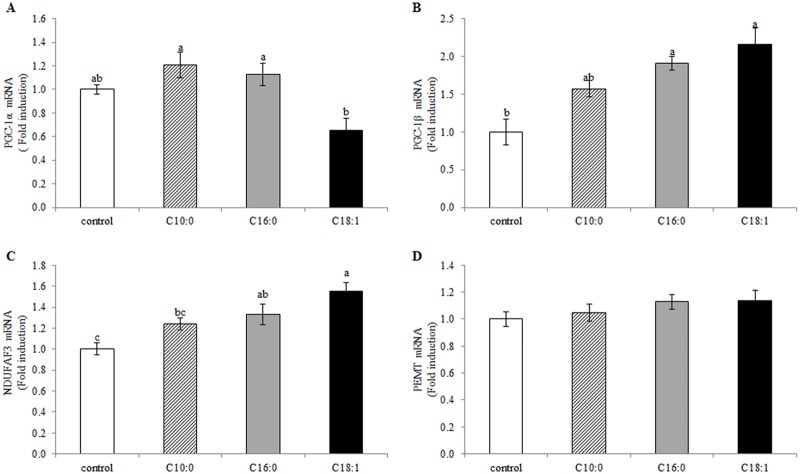
Transcription levels of activity markers of mitochondria and phospholipid converting enzyme are modulated by free fatty acids (FFAs).Mammary epithelial cells were treated with 100 μM FFA (capric, palmitic or oleic acid) or with FFA-free medium (control) for 2 h; RNA was extracted and gene-expression levels of (A) PGC-1α, (B) PGC-1β, (C) NDUFAF3 and (D) PEMT were analyzed by real-time PCR. All data are presented as mean ± SEM of the expression level of the assayed gene normalized to the geometric mean of two housekeeping genes. Different letters indicate significant differences between treatment groups (P < 0.05).